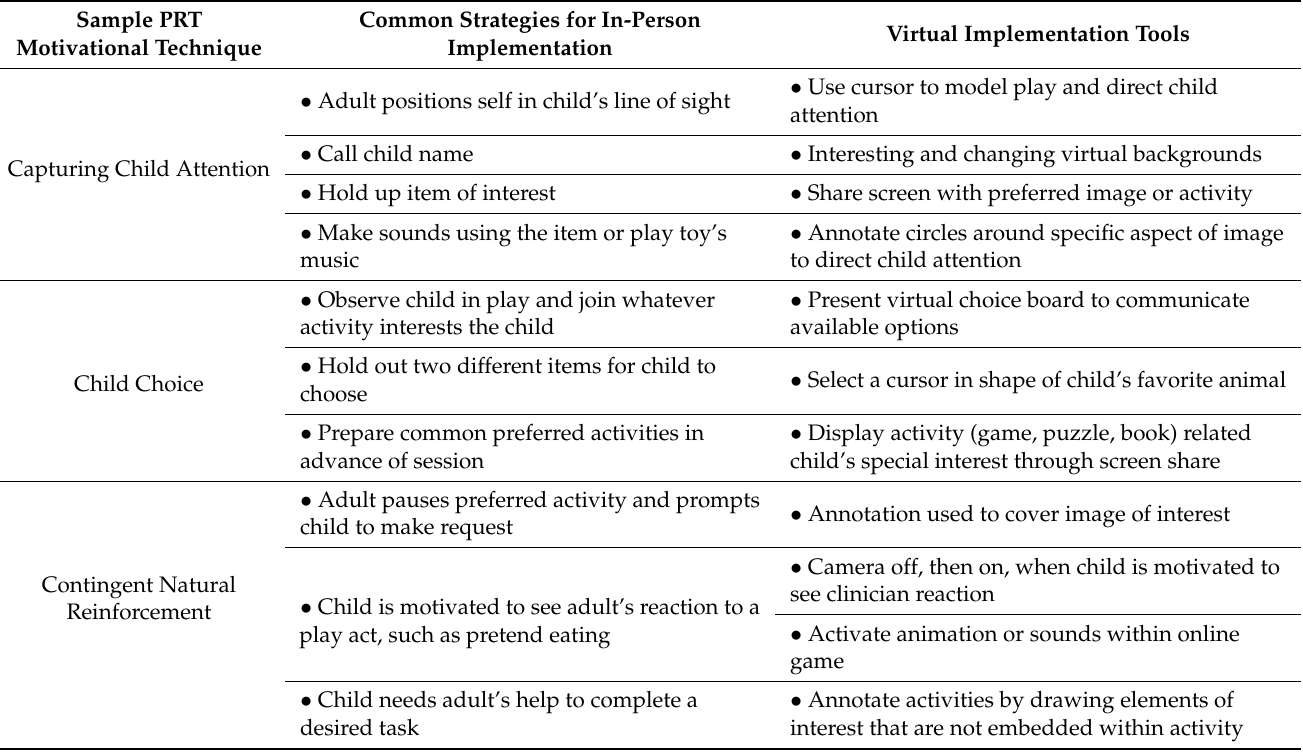
Table 1. Examples of Applying PRT Motivational Strategies via In-Person and Virtual Formats. Sample